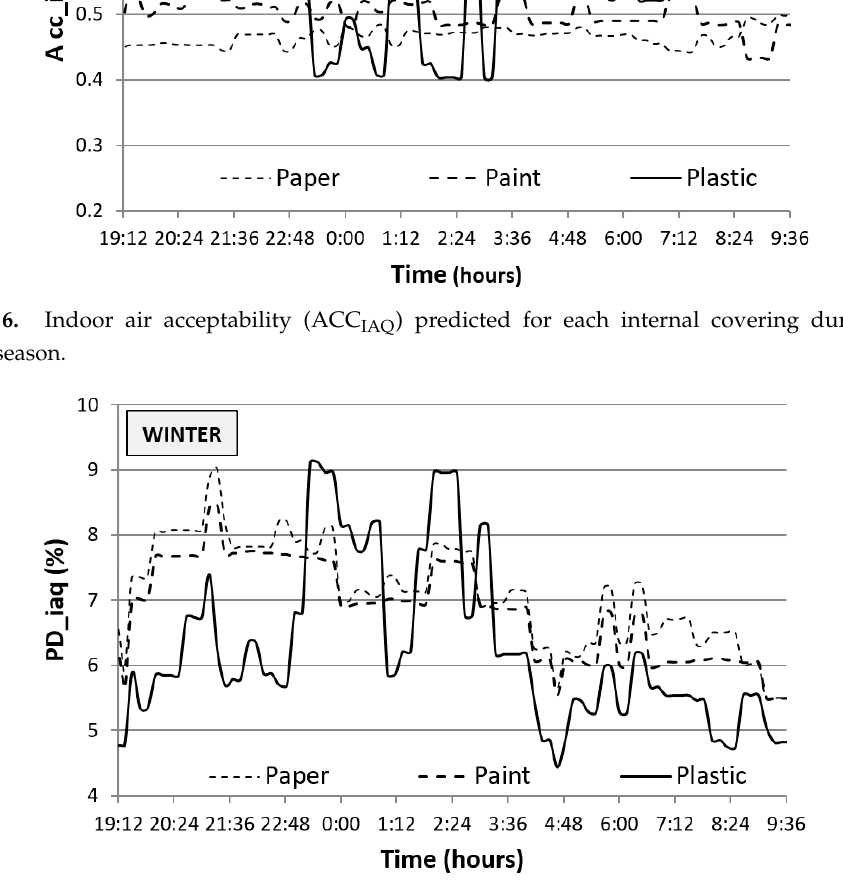
Figure 7. Indoor air percentage of dissatisfied persons (PD IAQ ) predicted for each internal covering during the winter season.